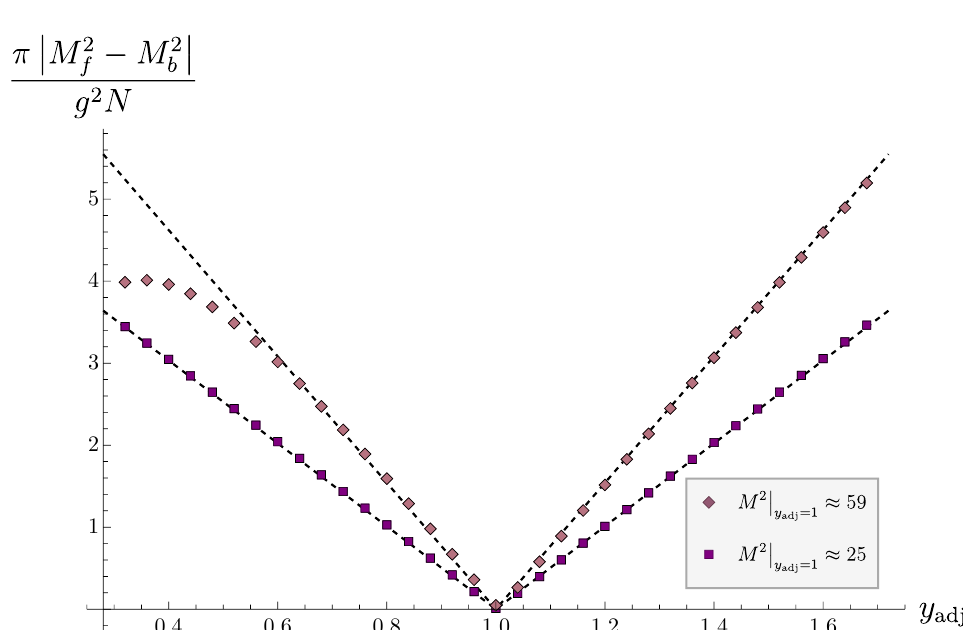
Figure 5 . For the lowest two states in the SU(2) spectrum near the supersymmetric mass y adj = 1 , we plot the absolute difference between the extrapolated continuum boson and fermion masses in the first lowest two doublets as a function of y adj . We find that they have equal masses (up to extrapolation error) at y adj = 1 . The dashed lines are the prediction of (4.7), which shows excellent agreement with the